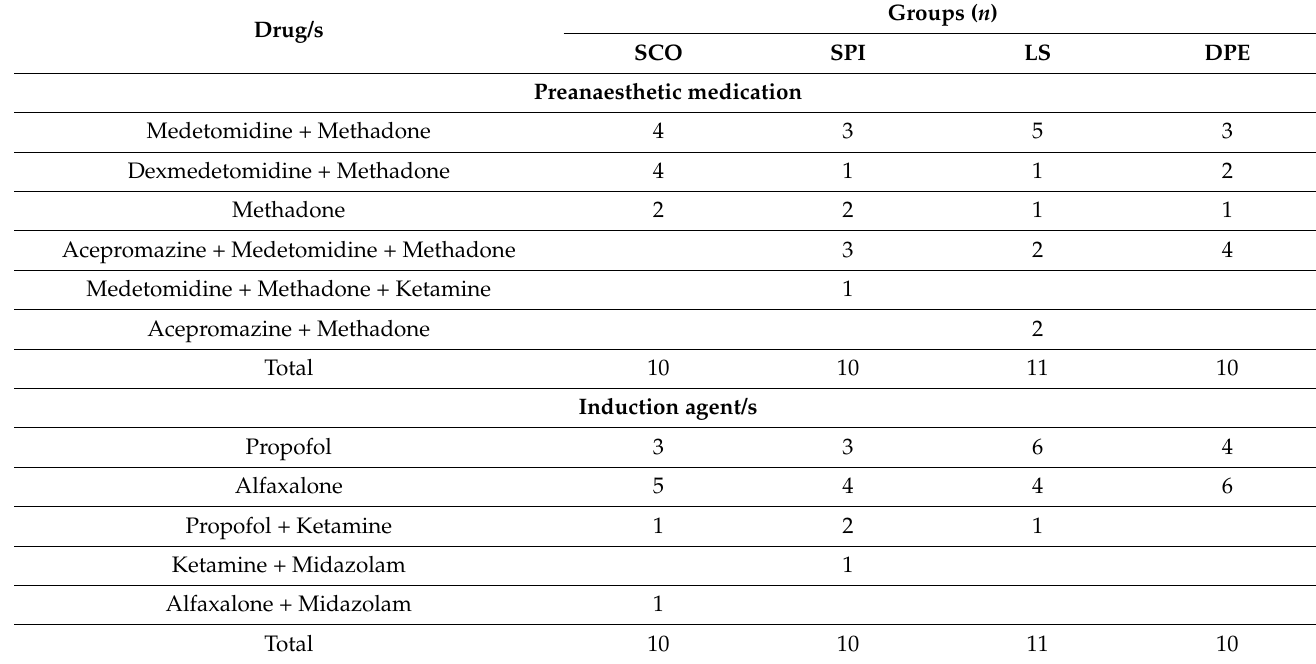
Table 3. Distribution of the different epidural drug combinations chosen by the attending anaesthetists, where ( n ) is the number of dogs per group. No statistical analysis was possible/performed. SCO, epidural injection in the sacrococcygeal space; SPI, injection in the subarachnoid space; LS, epidural injection in the lumbosacral space; DPE, dural puncture epidural